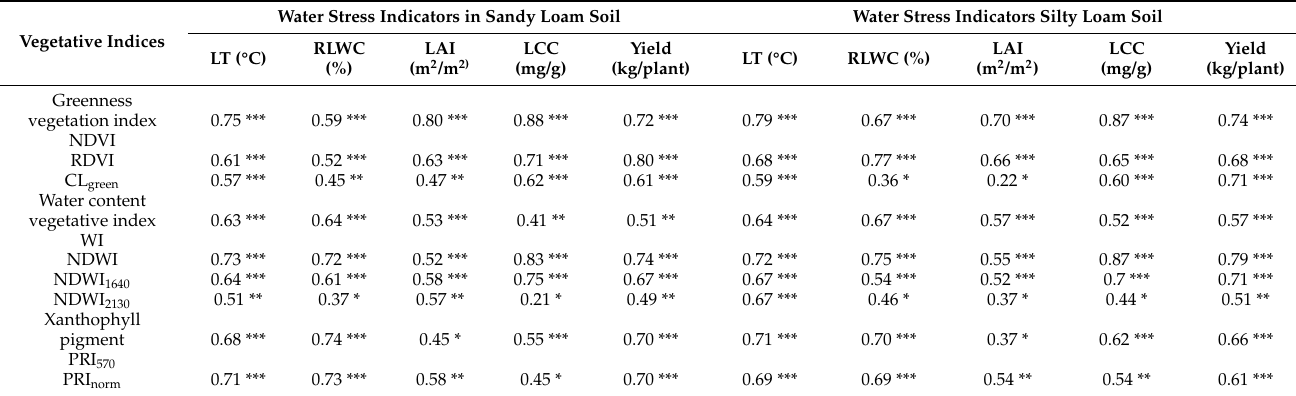
Figure 5. Relationship between LT °C and NDVI, RDVI, WI, NDWI, PRI570, PRInorm, derived from the various treatments in sandy loam and silty loam soils. (A) denotes sandy loam soil, while (B) denotes silty loam soil.) (*** denotes a p 0.001 association).